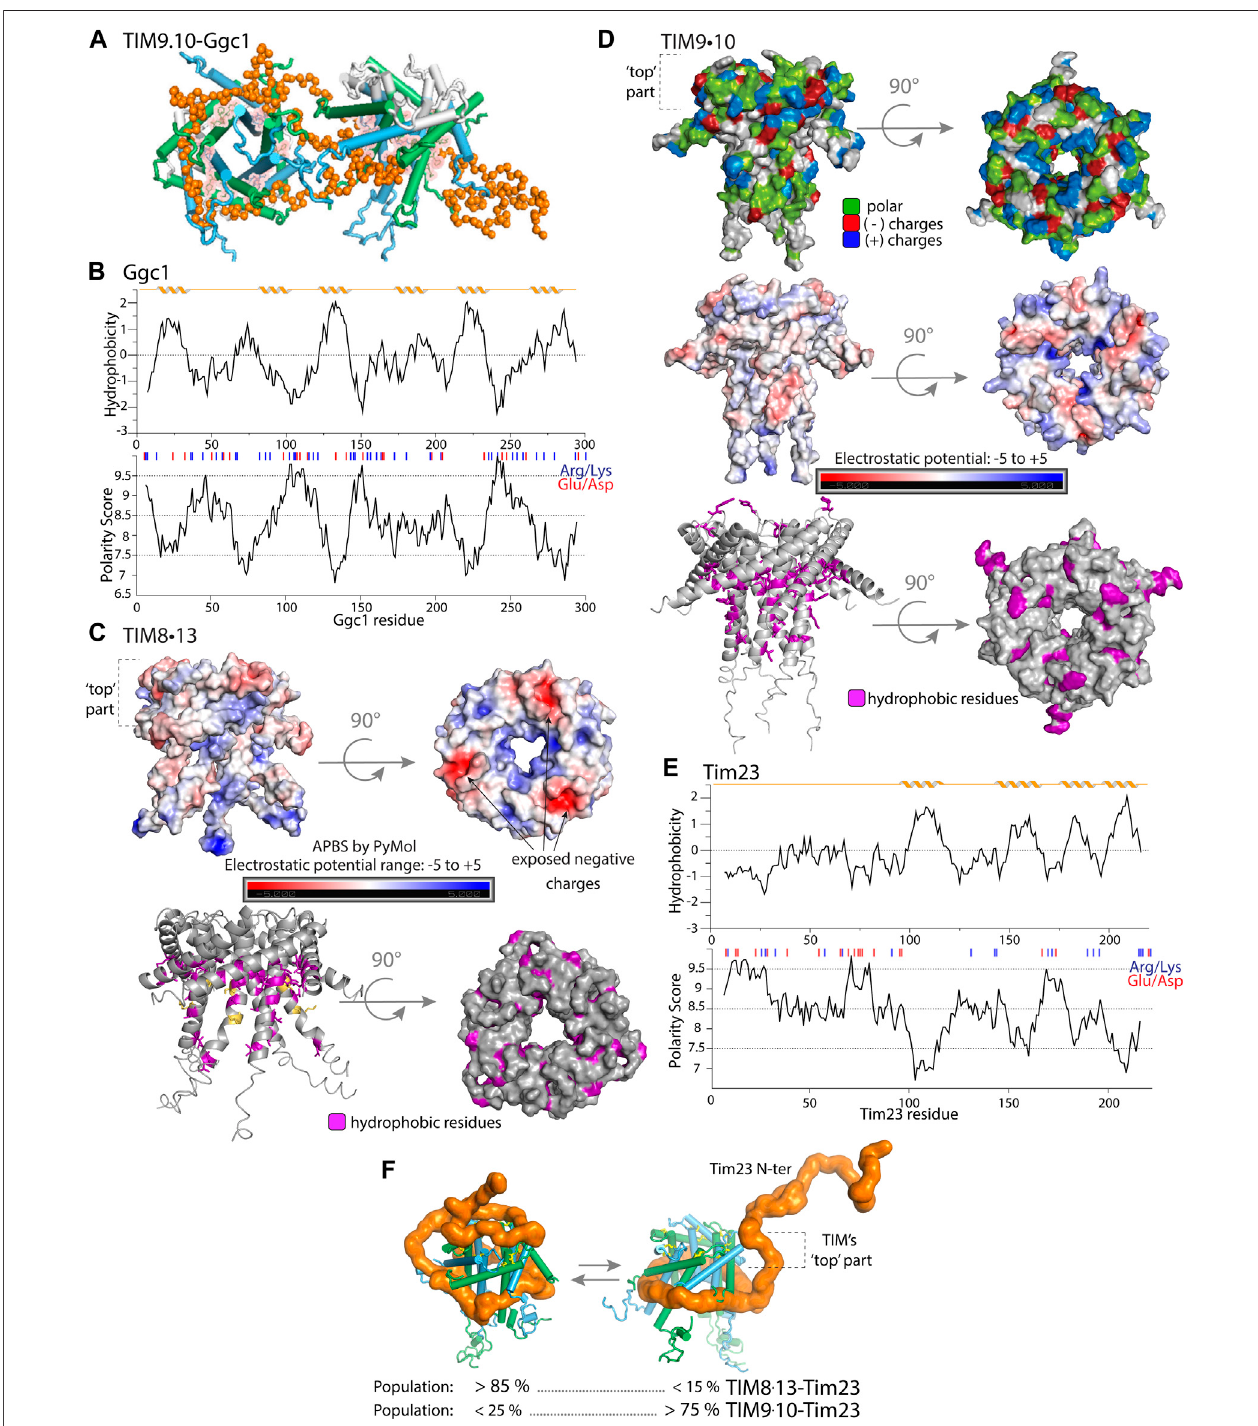
FIGURE 3 | Properties of mitochondrial intermembrane space chaperones and their selected clients. (A) Representation of the structure of TIM9.10 (blue/green) holding full-length client GDP/GTP carrier (Ggc1, orange), as reported in Weinhäupl et al. (2018). In contrast to the complexes of TIM8.13, the entire client protein is bound to two chaperone molecules in the hydrophobic binding cleft of the chaperone. Figure adapted from Su č ec et al. (2020). (B) Properties of full length Ggc1 client protein. Hydrophobicity and polarity predictions were calculated as mentioned for Tim23. (C) Properties of TIM8.13 chaperone (PDB 3cjh). In the upper panel the electrostatic potential is mapped on the TIM8.13 structure (model with extended tentacles), calculated with PyMOL APBS plugin. The molecule was prepared with the pdb2pqr method and the script was run with the standard setup (range of ± 5.00, grid spacing 0.5). The top part of the chaperone shows more exposed negatively